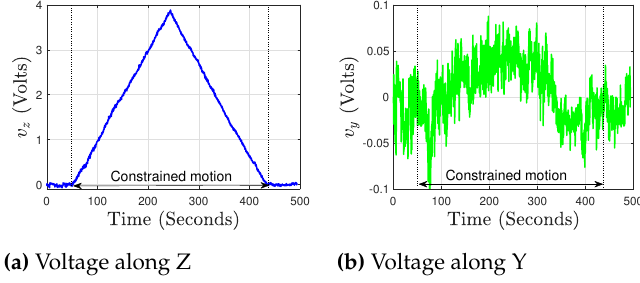
Figure 13. Characterization of PRT along Z.